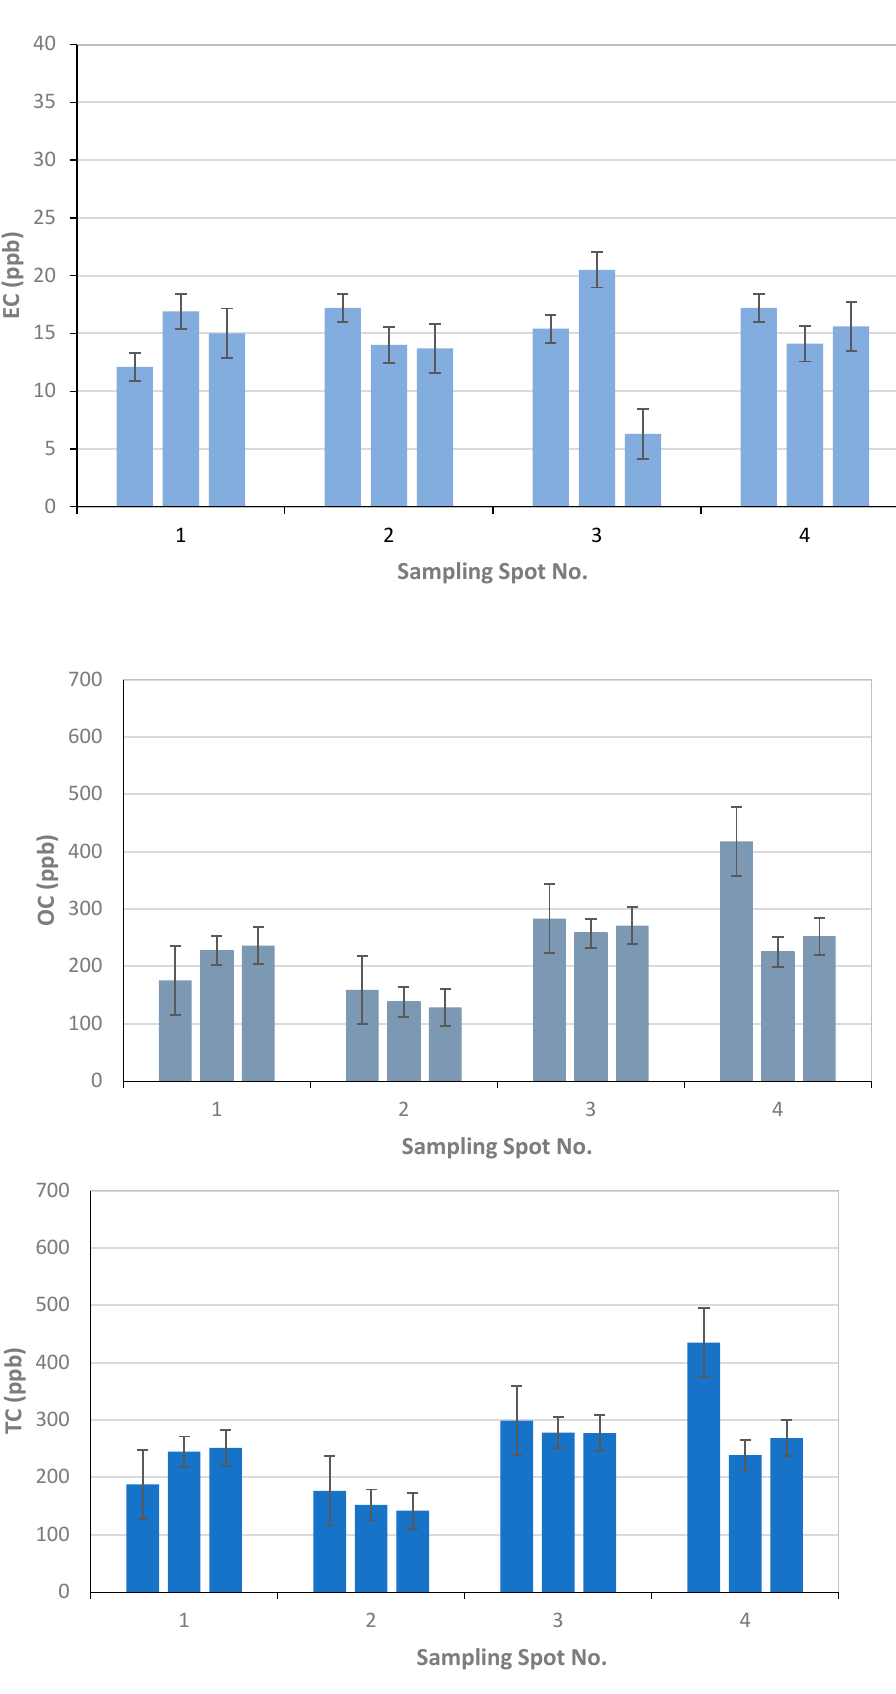
Figure 9. Finnish Meteorological Institute results for EC, OC, and TC concentrations using three replicates per sample filter from the four sampling spots 1–4 and associated standard error bars calculated from the three replicates of one sample.